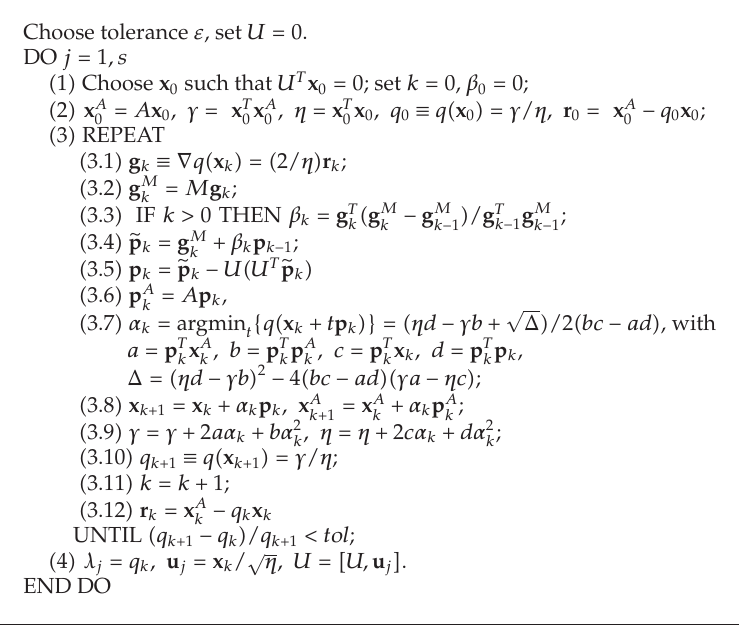
Algorithm 1: DACG